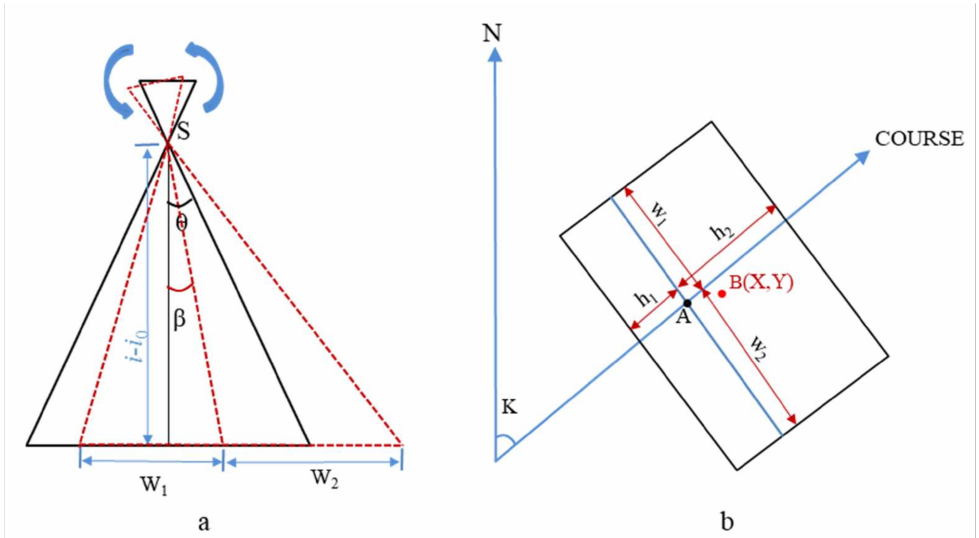
Figure 6. Image mapping area and image centroid correction